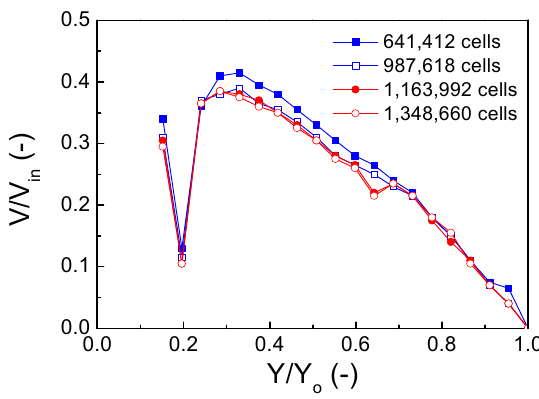
Figure 3. Grid independence test (with time step of 0.1 s). Atmosphere 2017 , 8 , 23